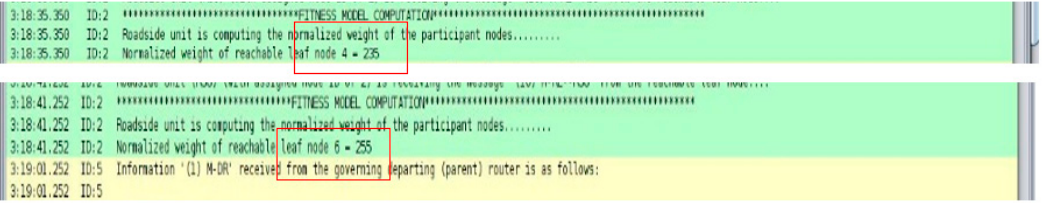
Figure 14. The outcome of computing the fitness values based on Cooja.